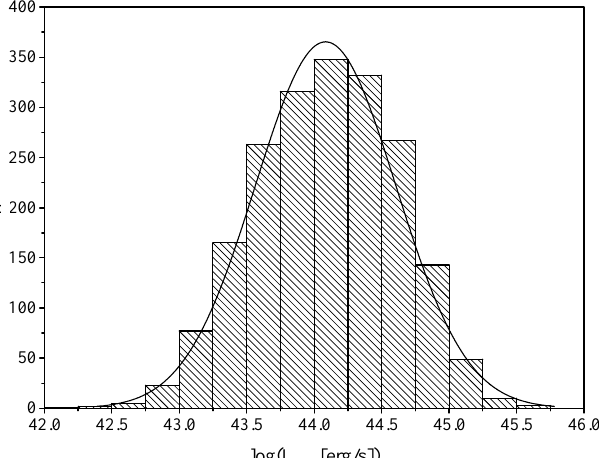
Figure 1. The distribution of the luminosity at 5100 Å L 5100 (with a fitted log-normal distribution curve) from the initial set.